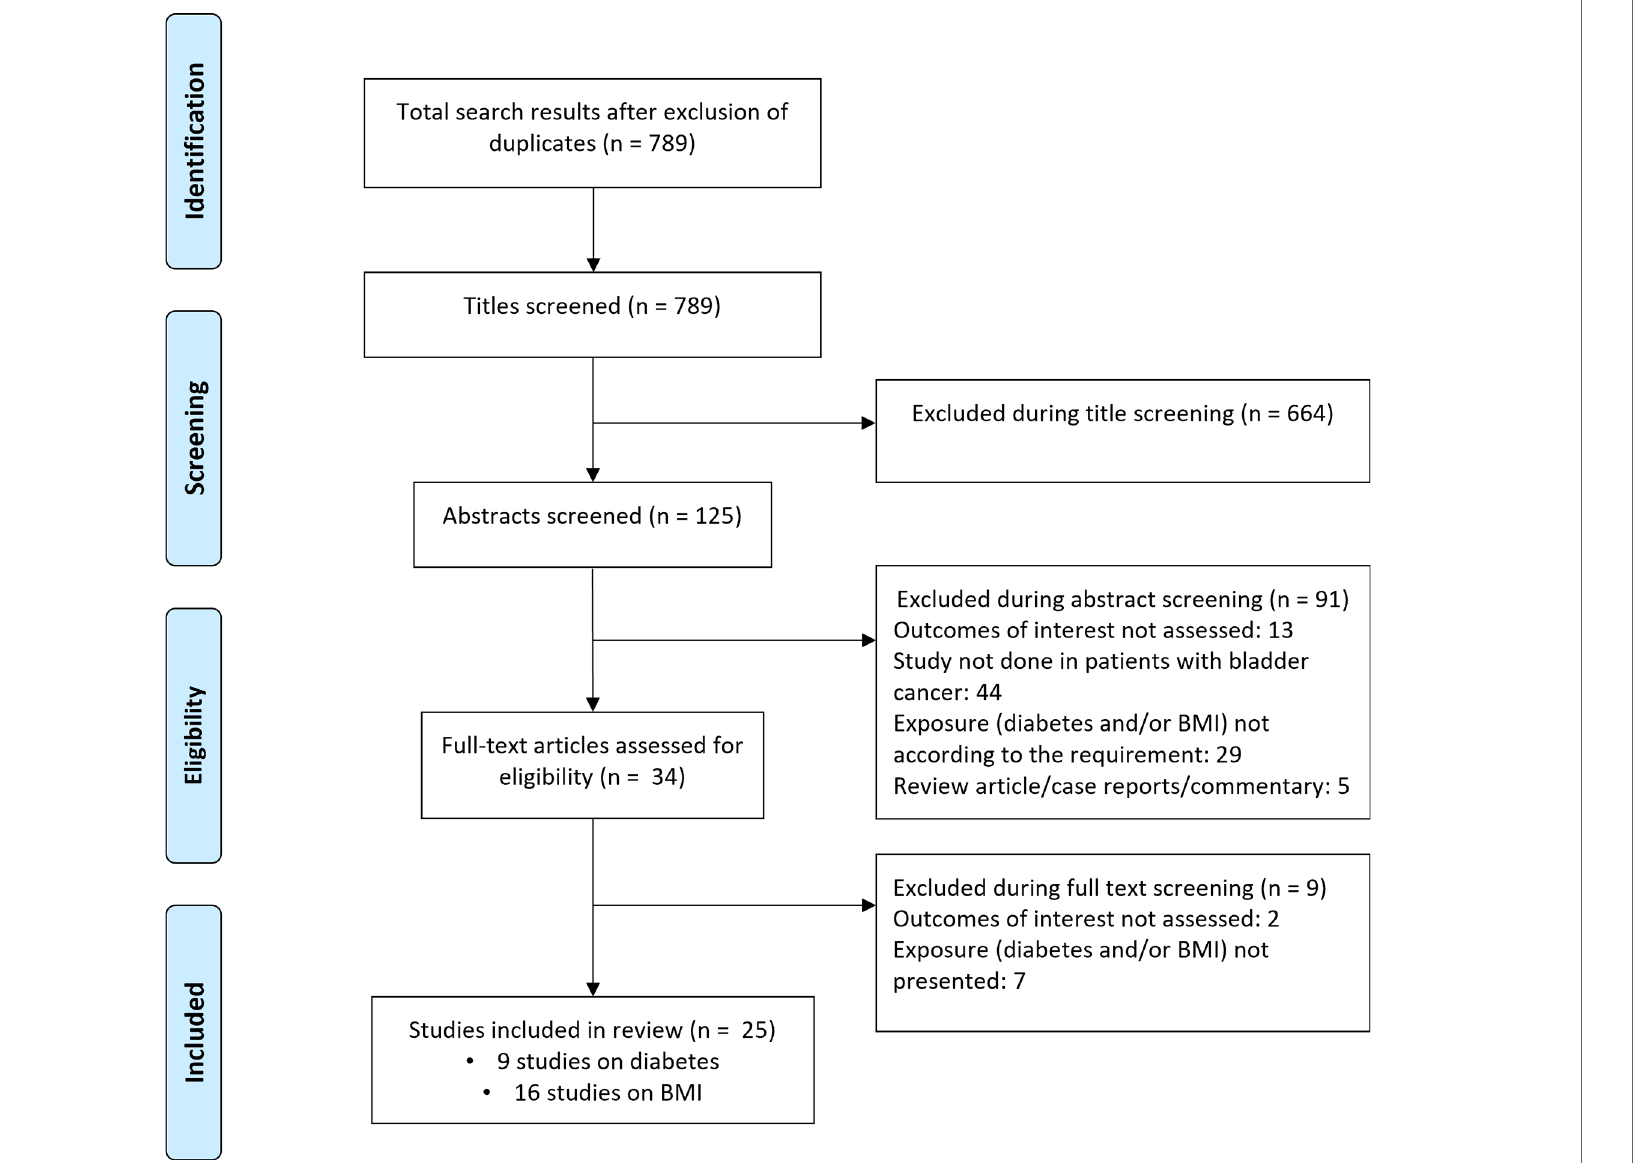
FIGURE 1 | Study inclusion